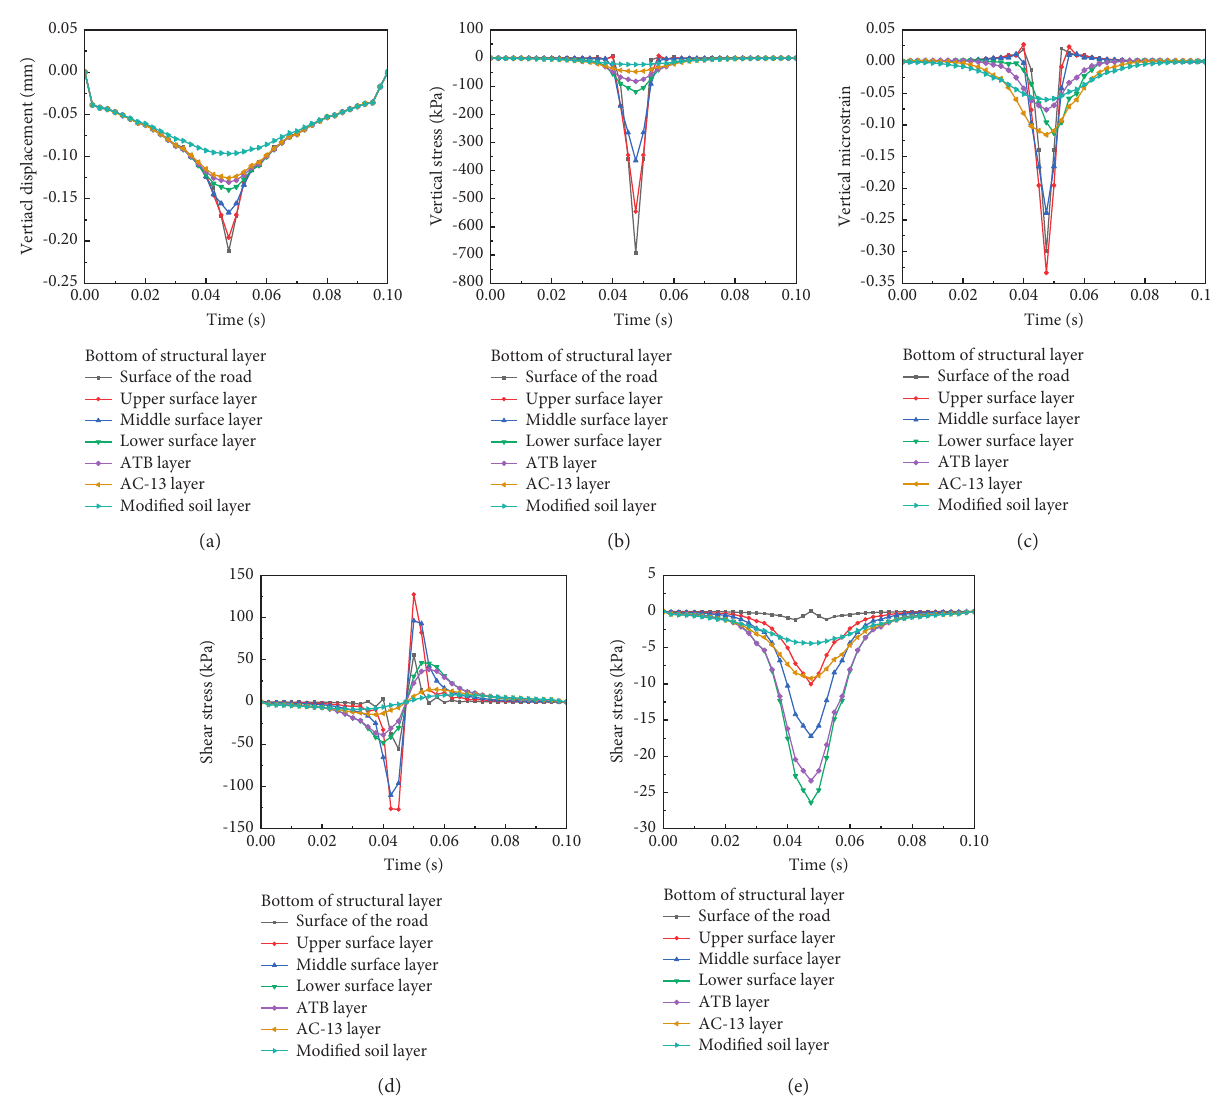
Figure 7: Time history curve of (a) vertical displacement, (b) vertical stress, (c) vertical micro strain, (d) longitudinal shear stress, and (e) transverse shear stress at each layer of structure